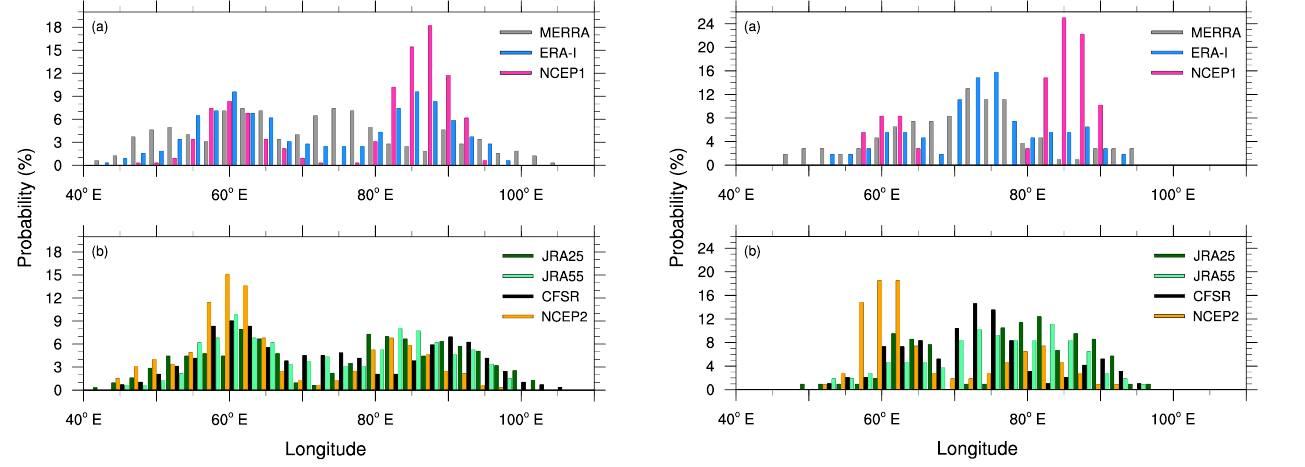
Figure 6. As Fig. 5 but for monthly mean data. Additionally the original distribution has been smoothed using a running average over three grid points (7.5 ◦ ).